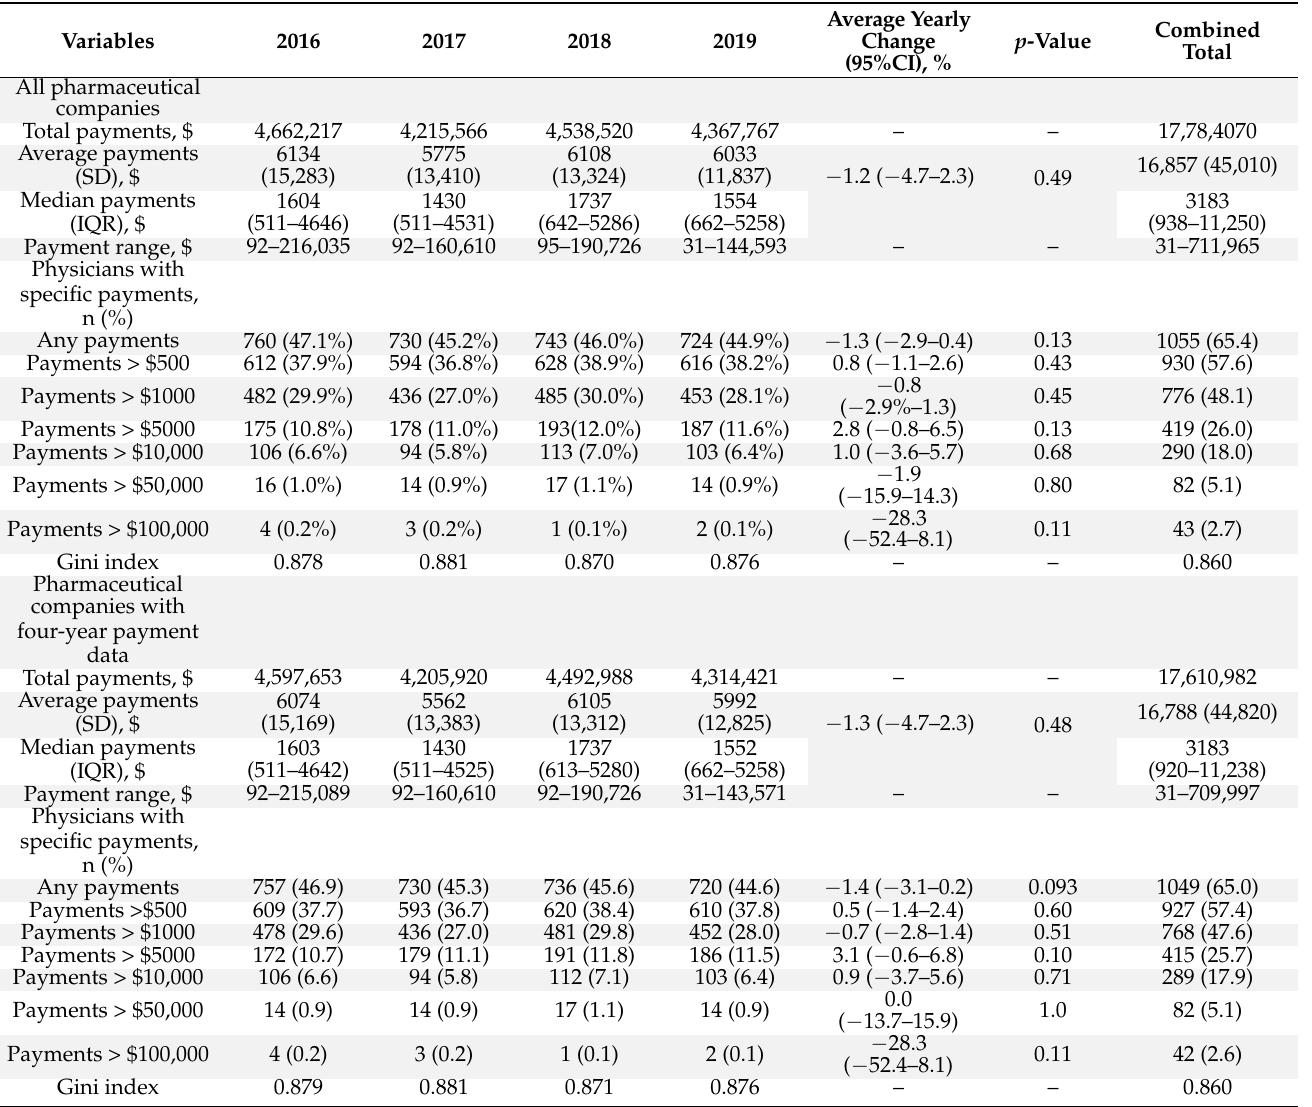
Table 2. Trends in personal payments from Japanese pharmaceutical companies to infectious disease specialists certified by the Japanese Association for Infectious Disease between 2016 and